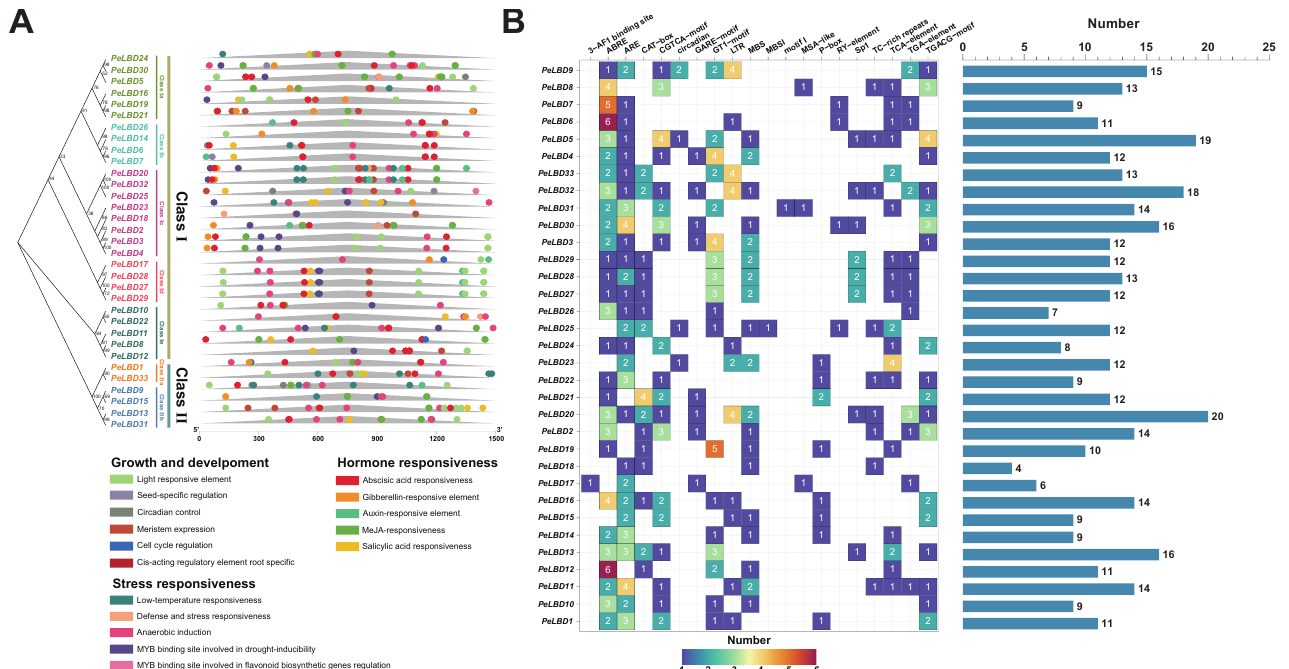
Figure 4. The cis -acting element on the putative promoter of the PeLBD genes. ( A ) Distribution of cis -acting elements identified in the 1500 bp upstream promoter region of PeLBD genes; ( B ) The number of cis -acting elements on putative promoters of PeLBD